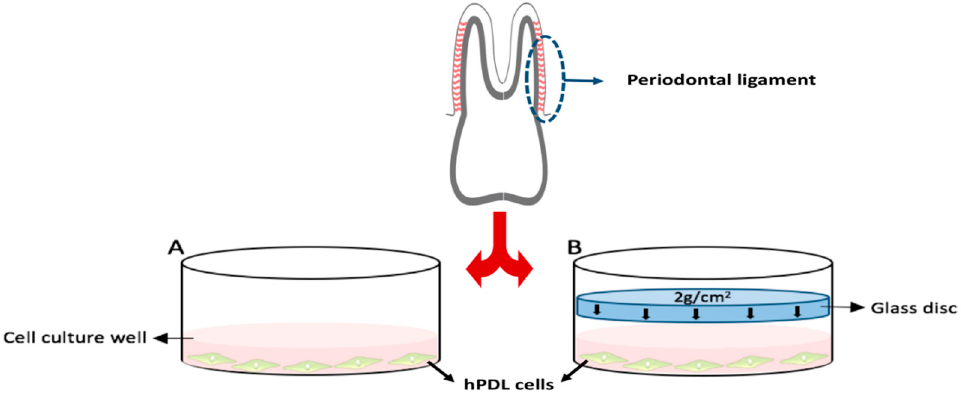
Figure 1. Experimental design. A—Physiological control (no pressure). B—Simulated orthodontic compressive force of 2 g/cm 2 applied by a 17.1 g glass disc (right side).